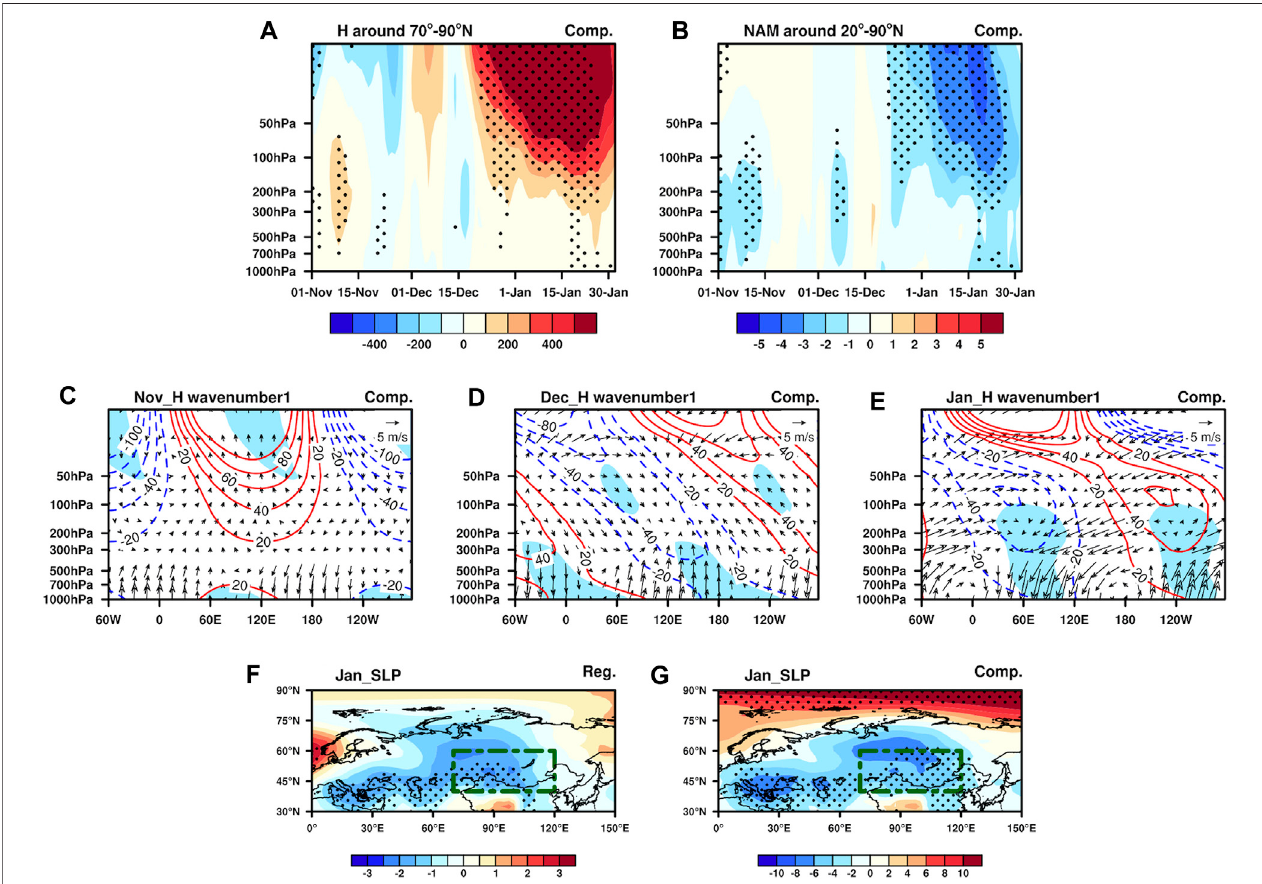
FIGURE7| CompositespatialpatternsofvariablesbetweenSSD H – SHI + − andSSD L – SHI − + during2000/01 – 2018/19: (A) time – pressurecross-sectioninthearea- averaged geopotential height anomalies (units: gpm) in the region poleward of 70 ° N; (B) time – latitude cross-sections of the meridional component of Northern Annular Mode index (the normalized time coef fi cient of the fi rst EOF mode of zonal-mean (20 ° – 90 ° N) geopotential height anomaly); (C – E) zonal wavenumber-1 distribution of geopotential height (contour, units: gpm) and WAF (vectors, units: m 2 s − 2 ) along a section at 50 ° – 70 ° N in (C) November, (D) December and (E) January.; (F) Regression of variables on the SSDI and (G) results of composite differences in January SLP between SSD H – SHI + − and SSD L – SHI − + ; Dotted (A, B, F, G) and shaded (C – E) regions are statistically signi fi cant at the 90% con fi dence level, based on the t -test.